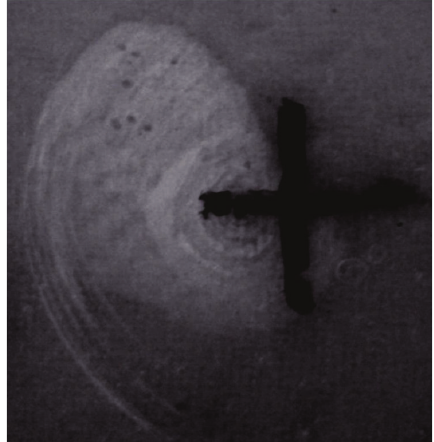
Figure 5: Sample delaminating area at the place of hitting after impact loading.